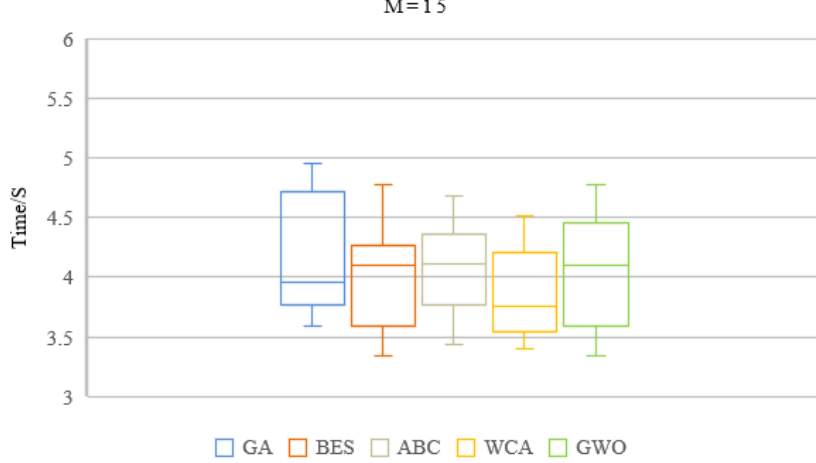
Figure 15. Running time box plot when the population is 15.